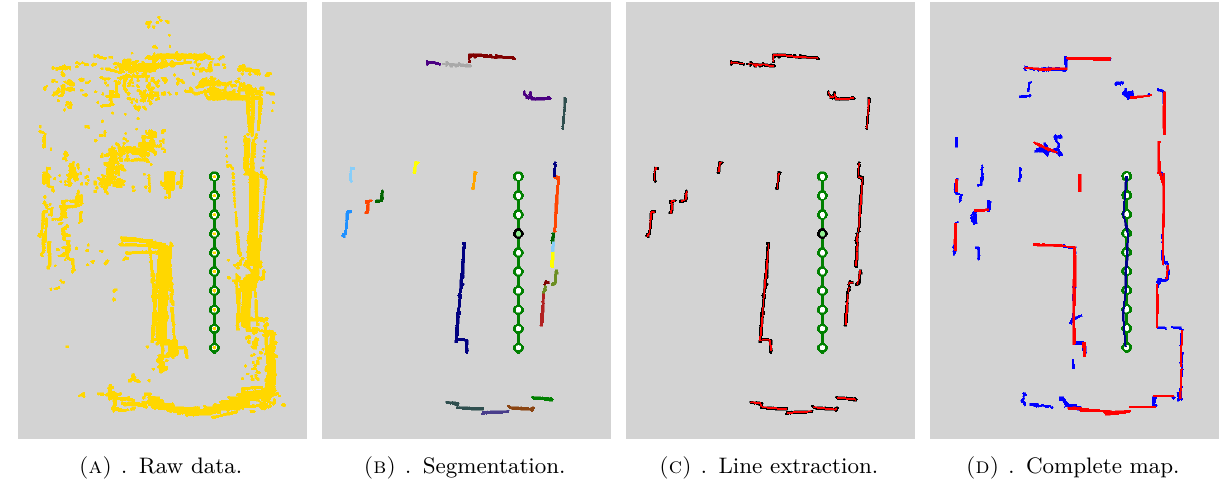
Figure 2. a) Depiction of all measured point clouds (yellow) with estimated robot path (green). No scan fitting or other postprocessing is used, image corresponds to raw data from sensors. b) Segmentation of one scan is shown on this figure. Each color means a cluster, which is believed to be continuous edge in reality and which is separate from the others. Noise and outliers are filtered out and not displayed. c) Line extraction in segmented point cloud (black). Each cluster is approximated by a line or a poly-line (red). d) A map composed using the line similarity criterion. Red edges are long enough to participate in scan fitting process, blue edges are shorter and just add details to the map. Green trajectory is acquired from odometry and dark blue one is an estimation of true